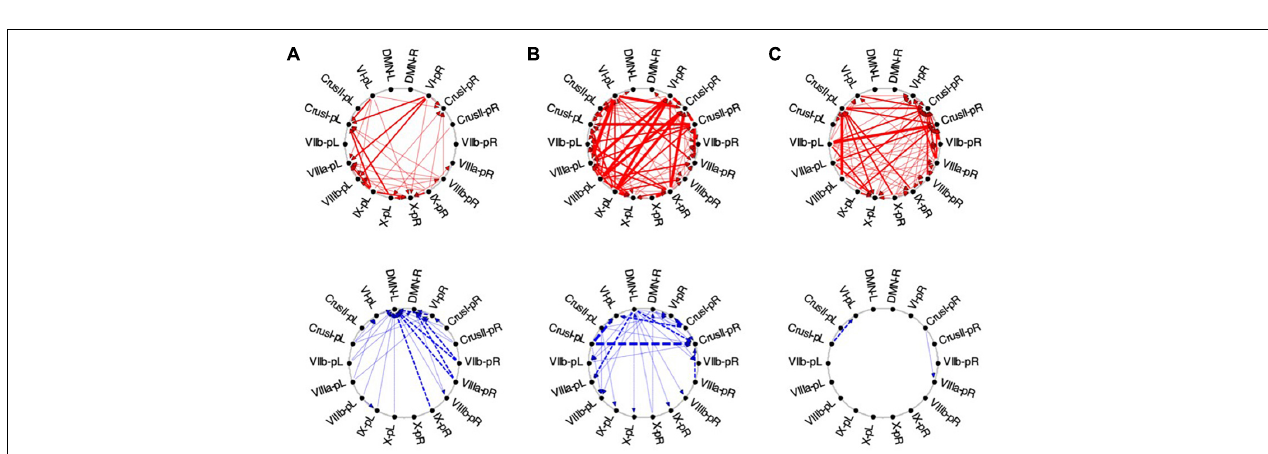
FIGURE 10 | Average Granger causal connectivity in Visualization ( Vis ) for the task-positive cerebellar ROIs with each other and with the cortical DMN . Connections are shown as arrowed lines if the directed connectivity is significant at p < 0.05, with line thickness coding connectivity strength, and red/blue color coding whether the influence is congruent or inverse relative to the BOLD signal (in separate upper and lower plots). (A–C) : Granger causal connectivity for Vis 1 , 2, 3 (the first through third visualization repeats). There is no congruent connectivity to the DMN in this task-positive ROIs, while the dominant inverse connectivity flows from almost all of these ROIs to the DMN initially, decreasing dramatically with task repeats.